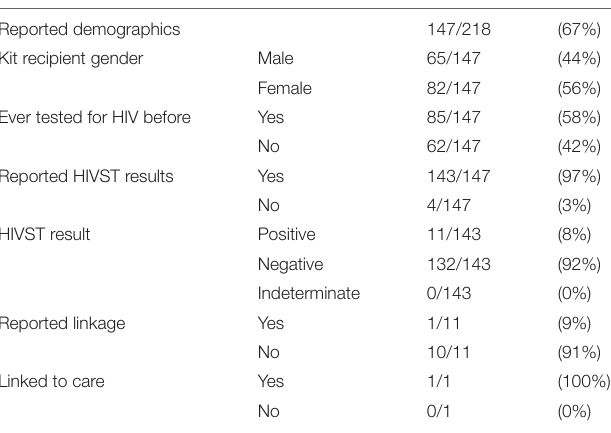
TABLE 2 | Kit recipient characteristics.